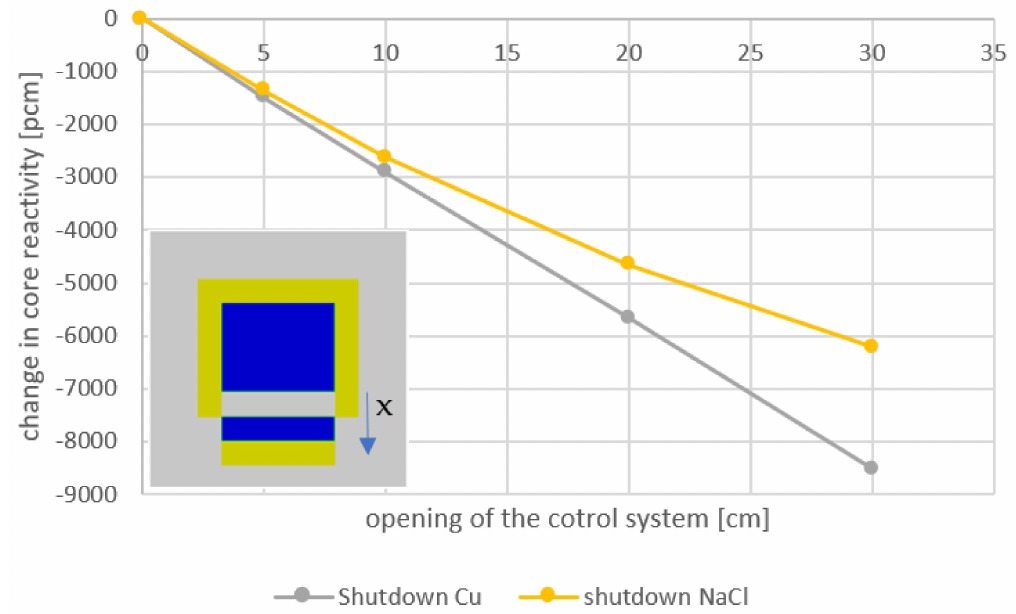
Figure 18. Comparison of the shutdown curve caused by moving the bottom part of the core for the reflectors made of NaCl and copper, with the systematics of the study described in the